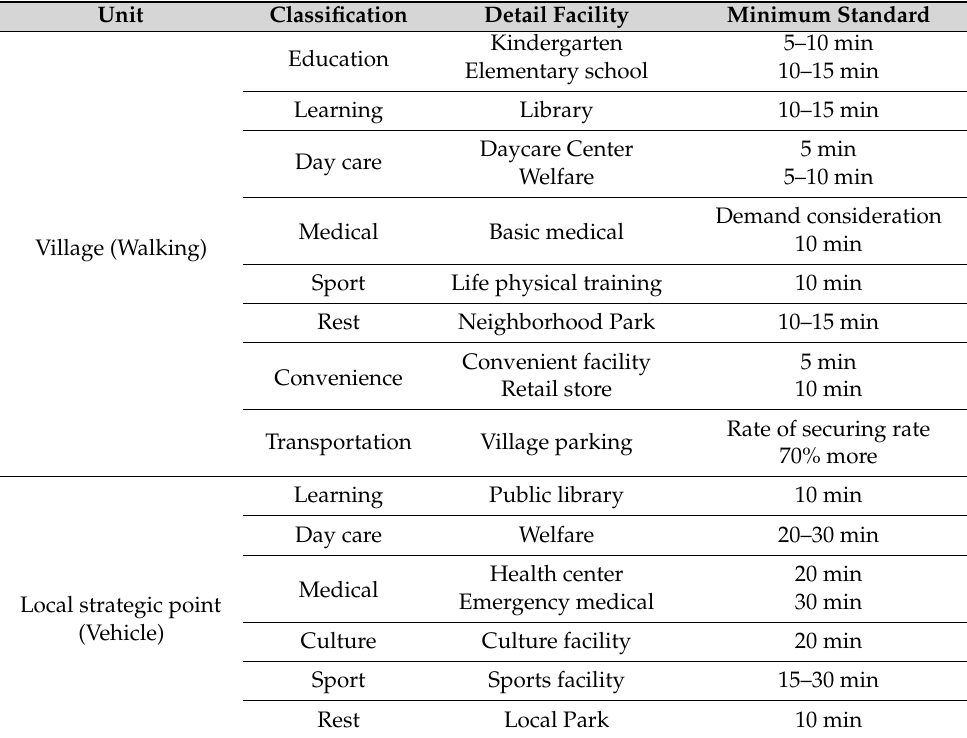
Table 1. The national minimum standard index.